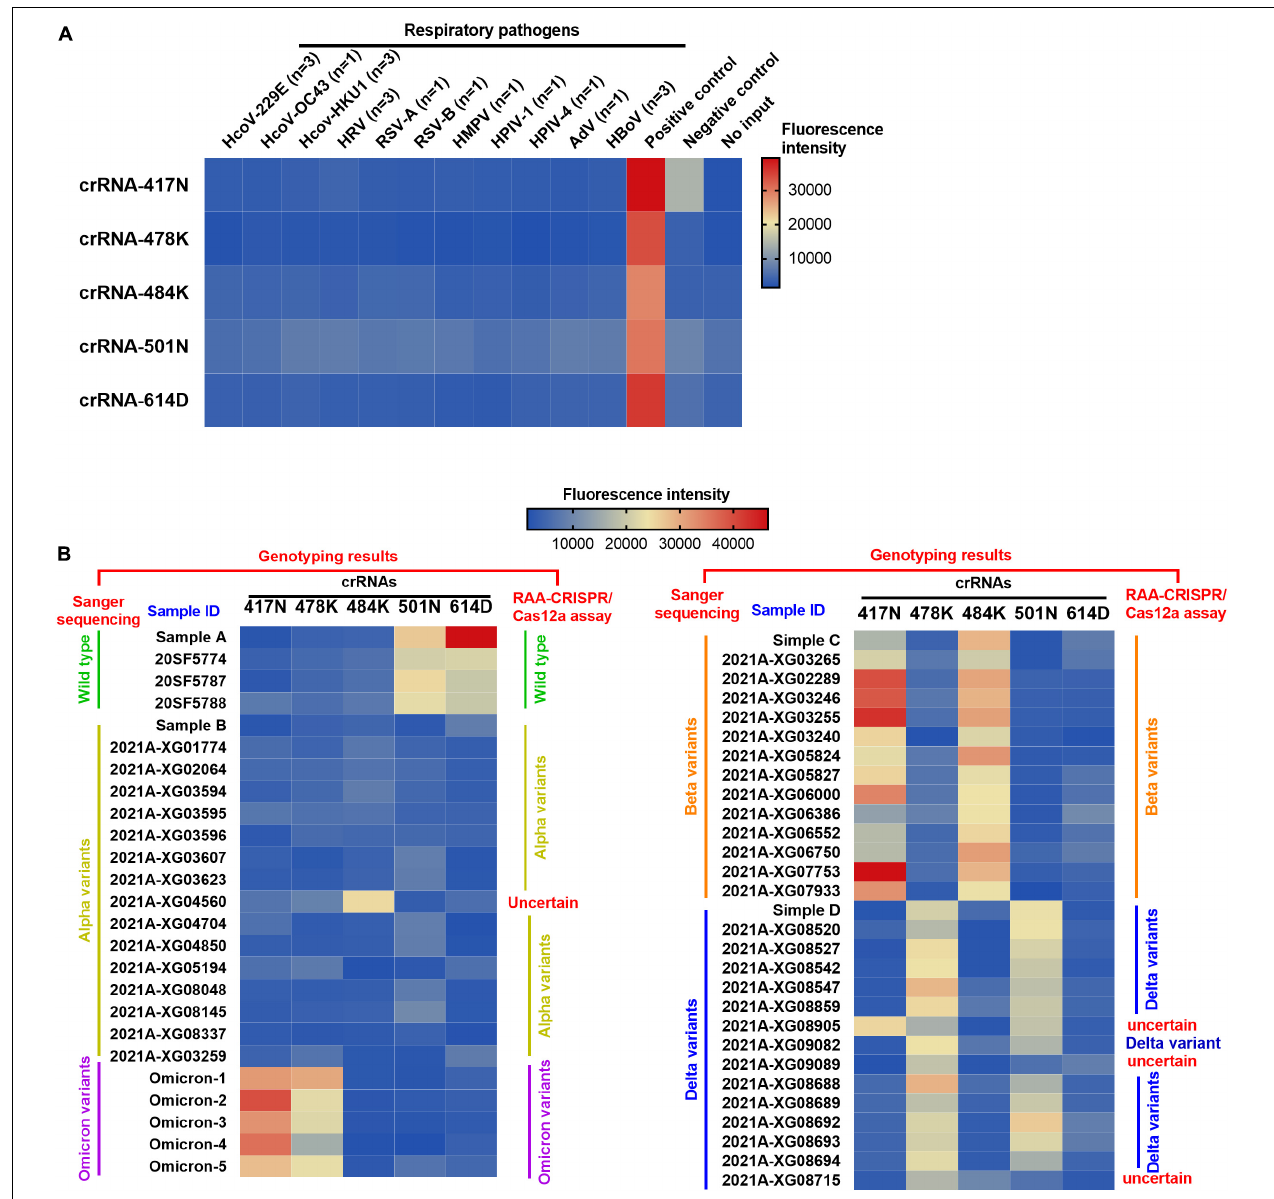
FIGURE 4 | Heat map for the testing results of SARS-CoV-2 positive clinical samples and negative controls detected by the RAA/CRISPR-Cas12a-mediated assay. (A) The DNA plasmid of SARS-CoV-2 S gene was used as positive control, while SARS-CoV-2 negative clinical samples infected with common human coronavirus (HKU1, 229E, and OC43), respiratory syncytial virus (RSV) A and B, parainfluenza virus (HPIV) 1 and 4, rhinovirus (HRV), adenovirus (AdV), human bocavirus (HBoV), and human metapneumovirus (HMPV) were used as negative controls to validate the specificity of our assay. No input refers to negative control. (B) A total of 54 SARS-CoV-2 positive clinical samples in a panel of 4 wild-type strains, 16 alpha variants, 14 beta variants, 15 delta variants, and 5 Omicron variants were detected by the RAA/CRISPR-Cas12a-mediated assay using a set of crRNAs including crRNA-417N, crRNA-478K, crRNA-484K, crRNA-501N, and crRNA-614D, which are indicated at the top of the panel. The sample ID is presented at the top of the panel. The genotyping results of Sanger sequencing and the RAA/CRISPR-Cas12a-mediated assay are presented at the left and the right of the panel, respectively. Uncertain means that the genotype could not be determined based on our RAA/CRISPR-Cas12a-mediated assay. The corresponding fluorescence values were displayed in colors. The scale bar shows the range of fluorescence values while the color change from blue to red represented the increased strength of